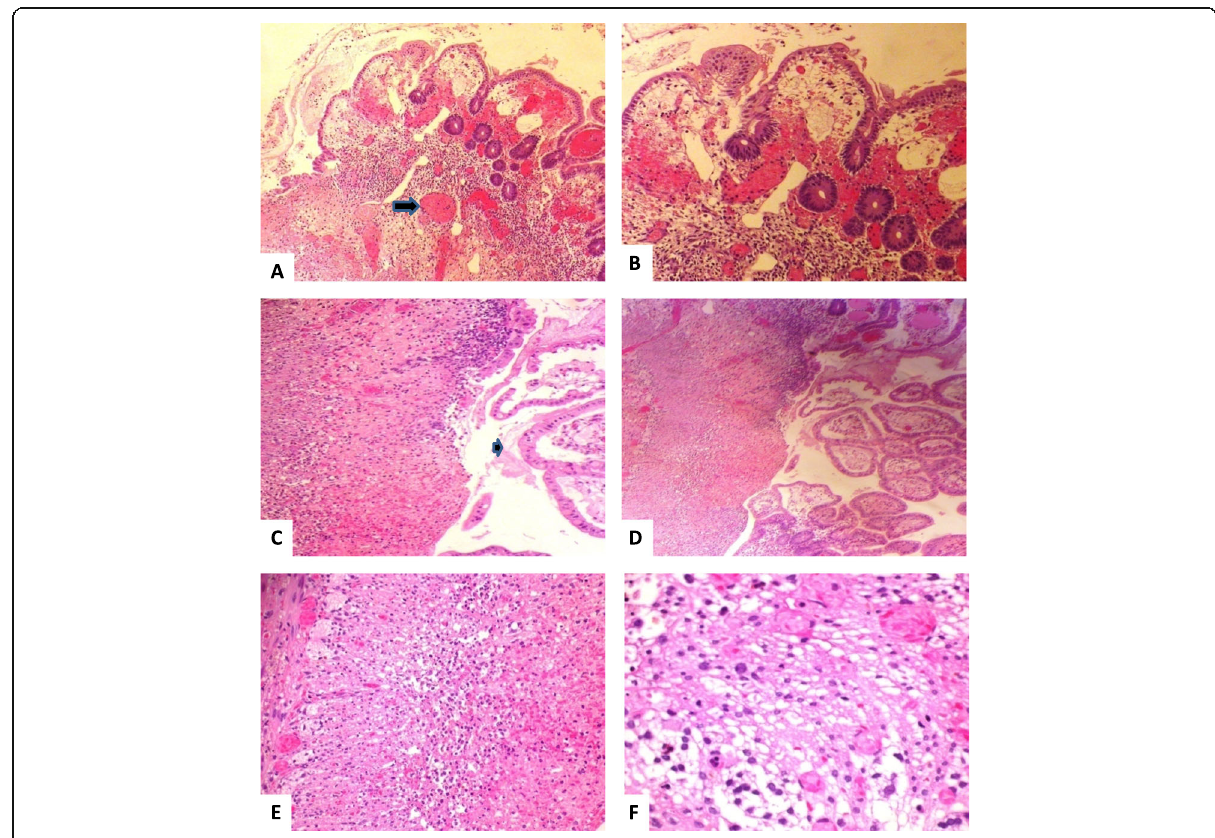
Fig. 2 a – f Histopathological changes in the small bowel showing various stages of intestinal injury. a , b There is disruption of the mucosal architecture (necrotic/degenerated materials on the mucosal side, loss of villus tip architecture, edema/hyperemia of the lamina propria, dilated lymphatics, and thrombus formation (arrow, a , b ). c – f The bowel is affected much more severely. There is necrosis of the mucosa and submucosa with intraluminal-degenerated materials on the mucosal side of the bowel wall (arrowhead), coagulative, and hemorrhagic necrosis of the submucosa and muscle layers ( d , arrow), associated with mixed inflammatory cell infiltrate including neutrophils, lymphocytes, and histiocytes ( e , f arrow) and vascular thrombosis ( e , arrowhead)